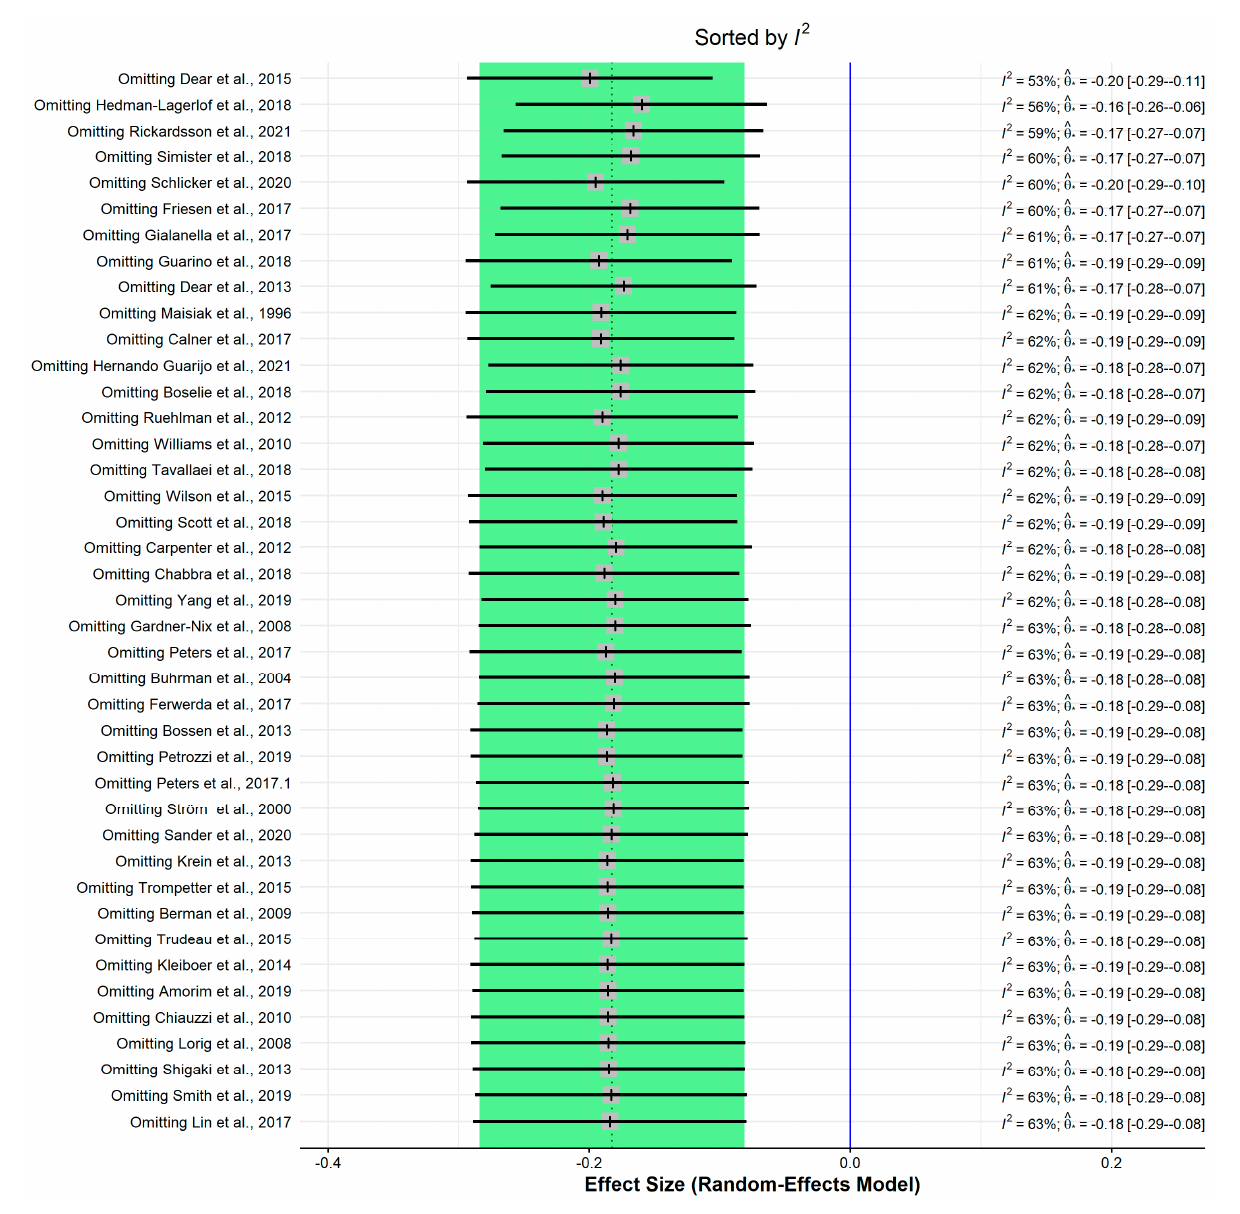
Contour-enhanced funnel plot of the studies included in the sensitivity